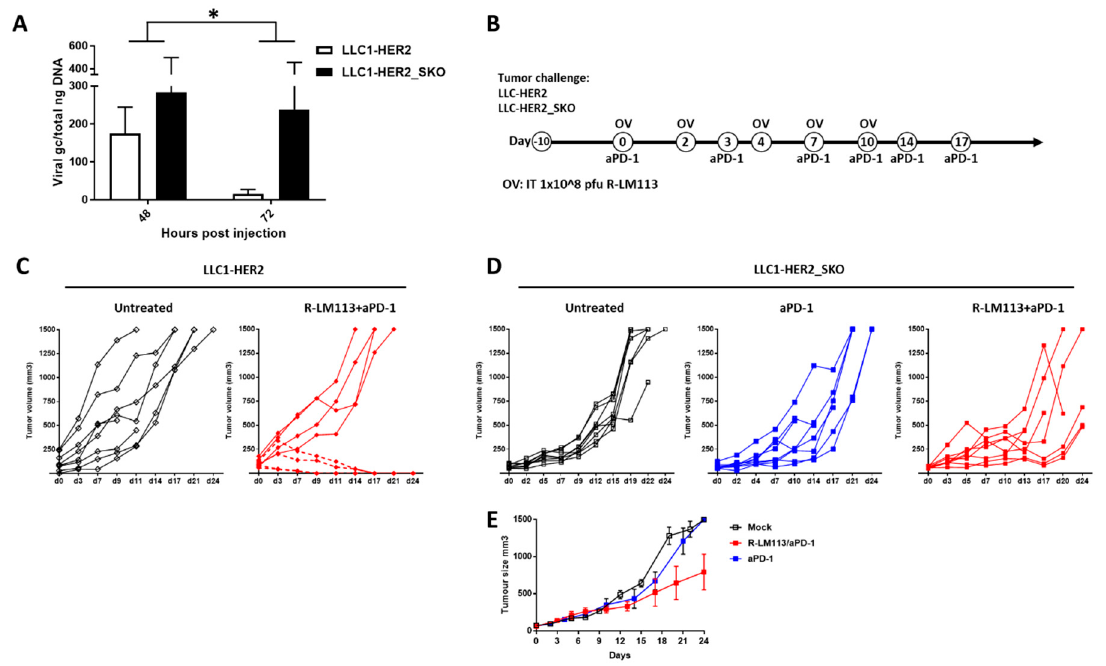
Figure 3. Tumor-resident STING influences oncolytic R-LM113 activity in vivo. ( A ) Evaluation of in vivo intratumoral viral replication in Sting wild-type and knockout LLC1 cell lines at 48 and 72 h after administration of R-LM113 (1E+08 viral PFU). Viral genome copies were quantified by TaqMan PCR and were normalized to total ng of extracted DNA. The statistical significance was calculated by two-way ANOVA (0.0148). ( B ) Schematic representation of the in vivo experimental setting. LLC1-HER2 wild-type and knockout cells were implanted subcutaneously into hHER2-transgenic/tolerant mice. When tumors became established (mean 110 mm 3 ), mice were randomized according to tumor size. Mice received 5 intratumoral injections of R-LM113 (1E+08 PFU/inj) at 0, 2, 4, 7, 10 days and six systemic administrations of PD-1 blocking antibody at days 0, 3, 7,10, 14, 17. ( C ) LLC-HER2 tumor growth in corresponding untreated (empty rhombuses) and combination treatment (red rhombuses). Dashed lines indicate complete responder mice. R-LM113 and PD-1 blockade monotherapy does not have in vivo efficacy [32–34] ( D ) LLC-HER2_SKO tumor growth for the three experimental groups: untreated (empty square), α -mPD-1 (blue) and combination (red square). For c and d, each line represents the tumor growth for individual mouse. The statistical significance for experiments described in panel c was calculated by Fisher’s and was 0.03. ( E ) Median tumor volume with SEM for mice presented in panel d.